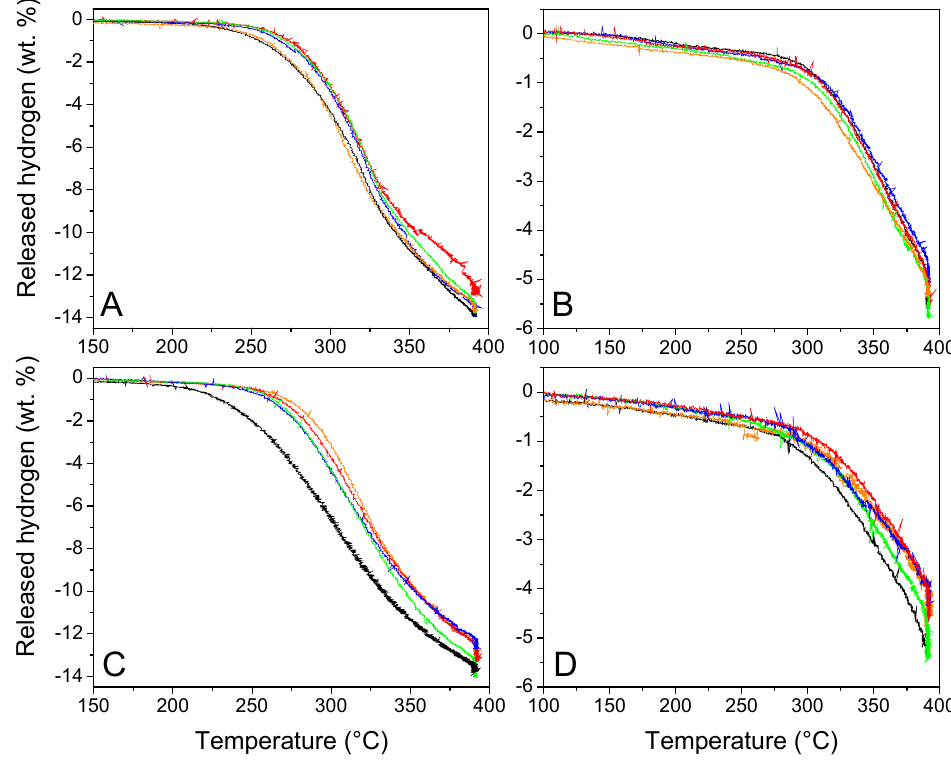
Figure 7. Volumetric studies of GN50 ( A , C ) G2N50 ( B , D ) without (black) and with Fe (orange), Co (red), Ni (green), and Cu (blue) nanoparticles during the first ( A , C ) and second ( B , D ) dehydrogena- tion cycles. Table 5. Hydrogen release capacity of GN50 and G2N50 with and without decoration.